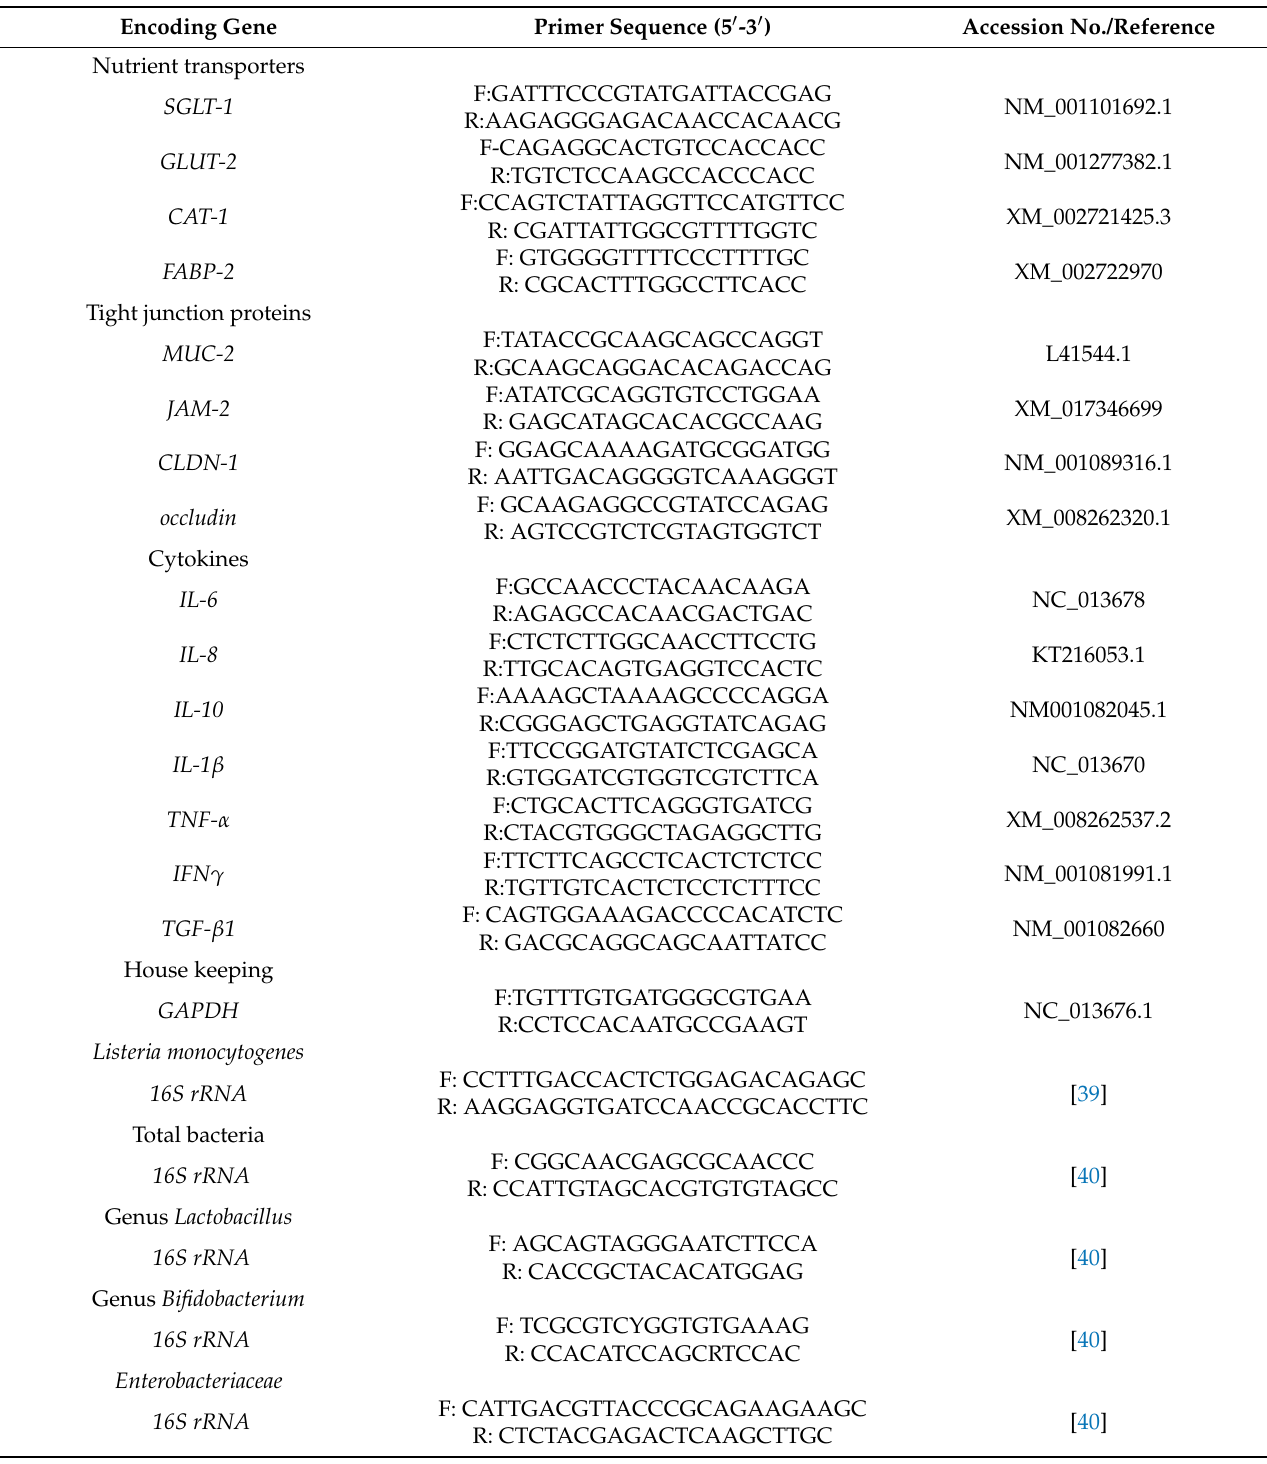
Table 2. Primer sequences of target genes analyzed in quantitative real-time PCR